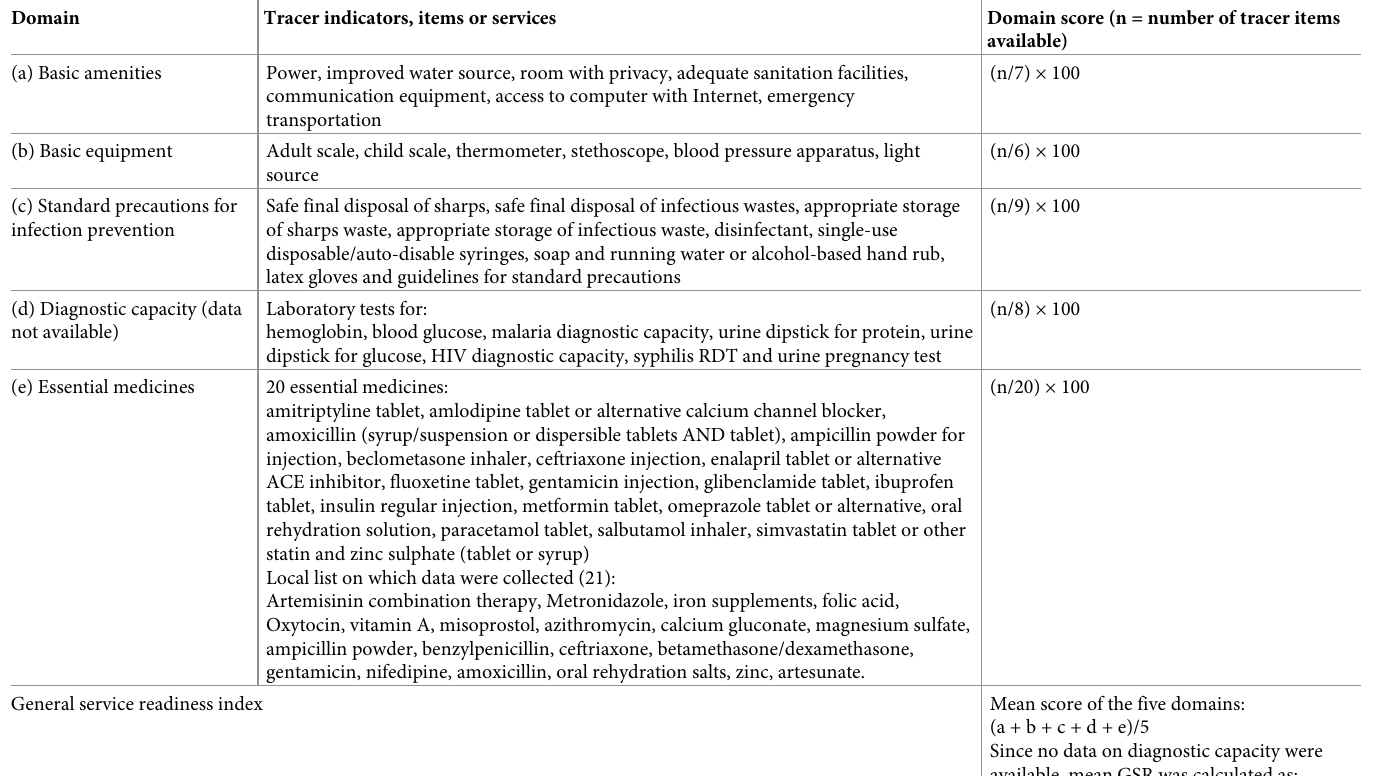
Table 1. SARA domains and tracer indicators for general service readiness.